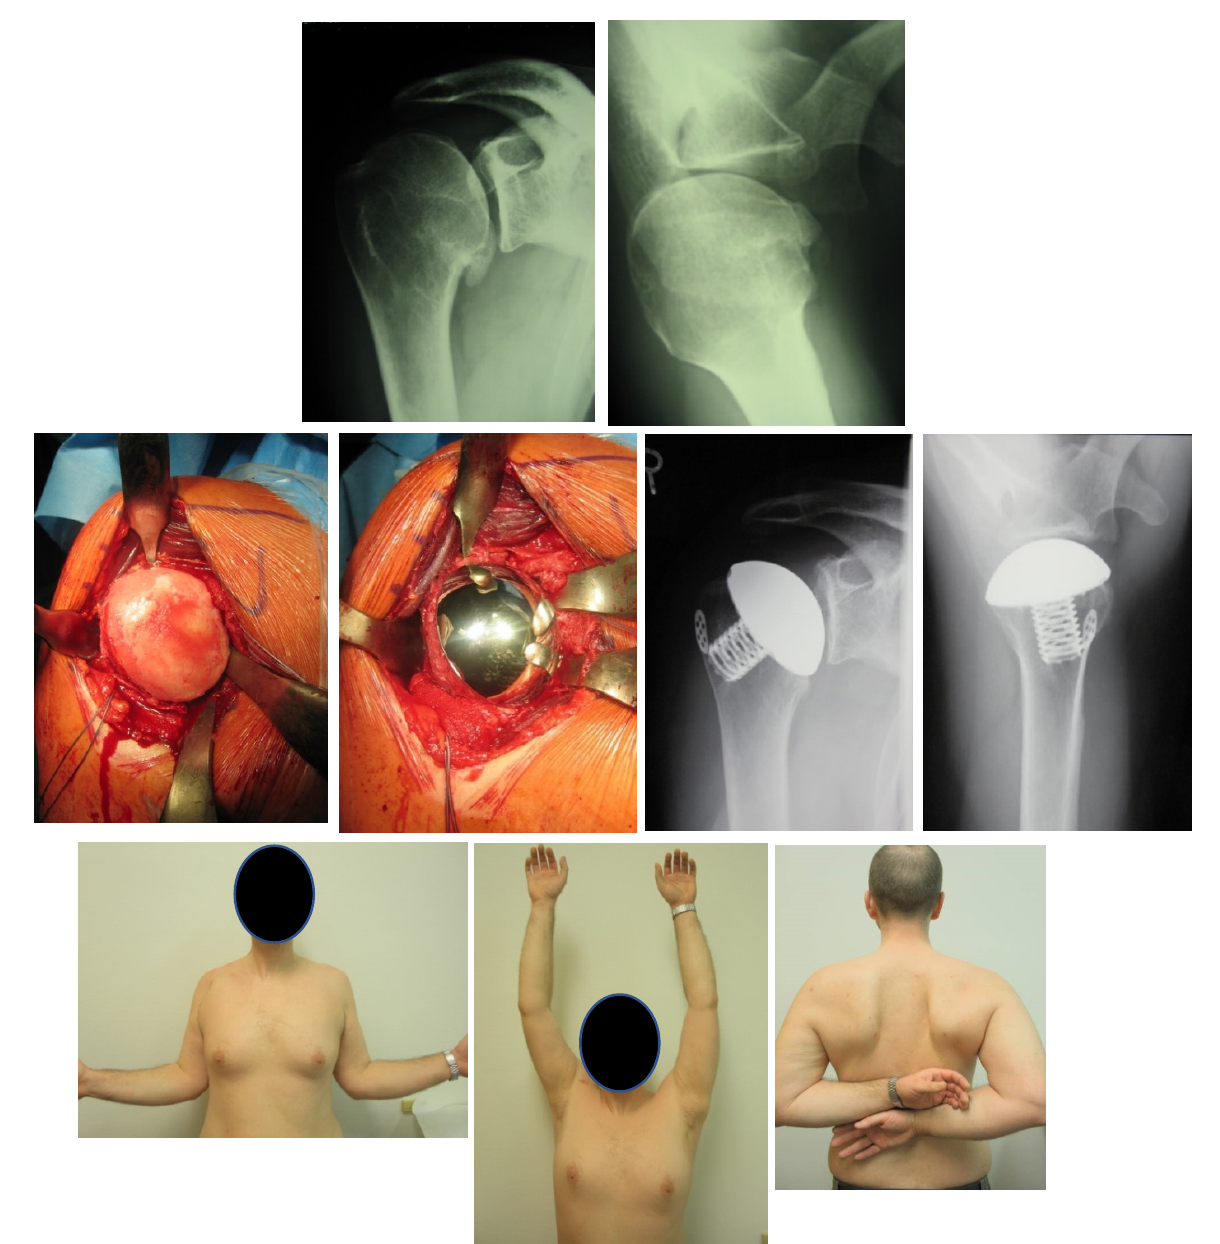
Figure 4. 43 year-old patient treated with hemiprosthesis after capsulorrhaphy arthropathy subse- quent to open instability repair. First row : preoperative radiographs. Second row : intraoperative pictures of hemiprosthesis implant and postoperative radiographs. Third row : Physical examination and shoulder function at final follow-up.